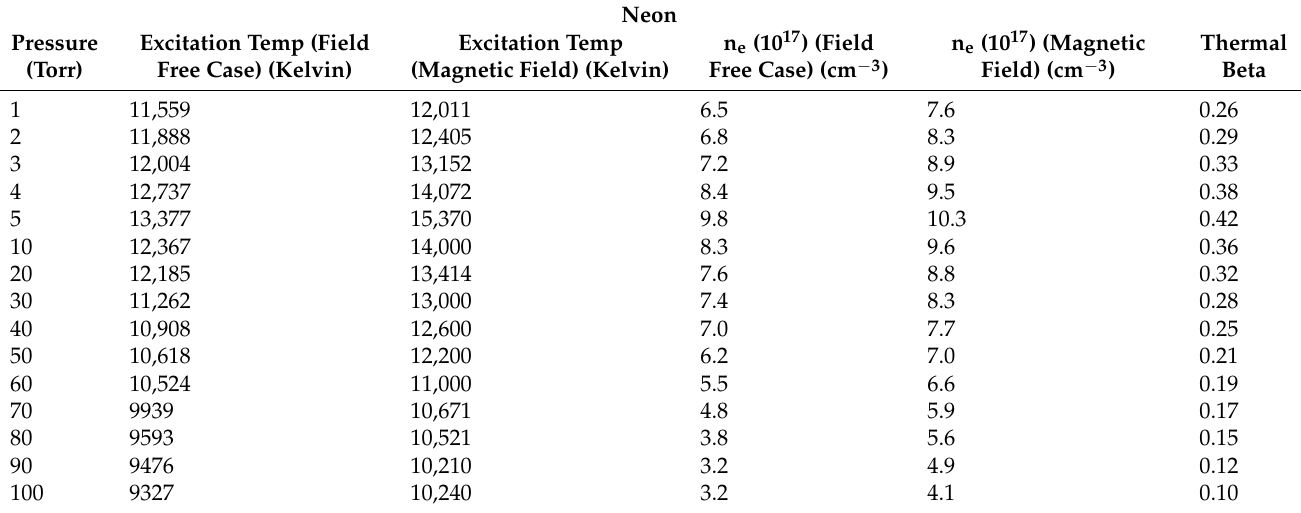
Table 3. Evaluated T exc , n e , and β t values for laser-irradiated Mg plasma at various Ne pressures in the presence and absence of TMF.